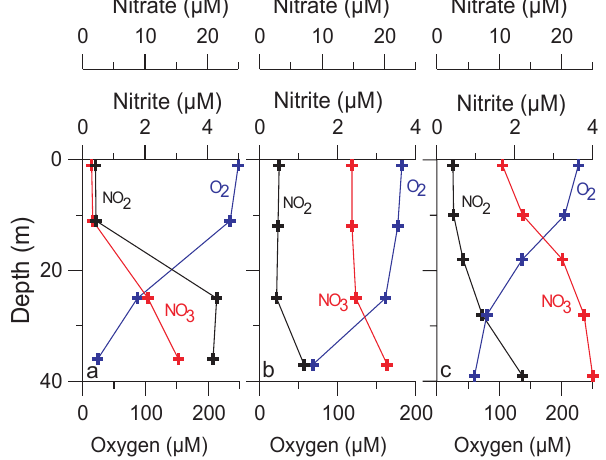
Fig. 6. Fe vs. NO − diagram showing drawdown scenarios with 3 various initial values of Fe and NO − for a region off California 3 Fig. 7. Vertical profiles of O 2 , nitrate (including nitrite) and shown to be Fe limited (from Bruland et al., 2001). Slopes change nitrite at three shallow stations located over the Omani shelf: as phytoplankton with lower Fe requirements take over. Cases 1–3 (a) Sta. SK209/09 (21.118 ◦ N, 59.149 ◦ E), (b) Sta. SK209/13 represent eventual Fe limitation. Data from our two stations plotted (19.838 ◦ N, 58.343 ◦ E), and (c) Sta. SK208/15 (18.661 ◦ N, on this diagram are indicative of Fe limitation in the Arabian Sea. 57.192 ◦